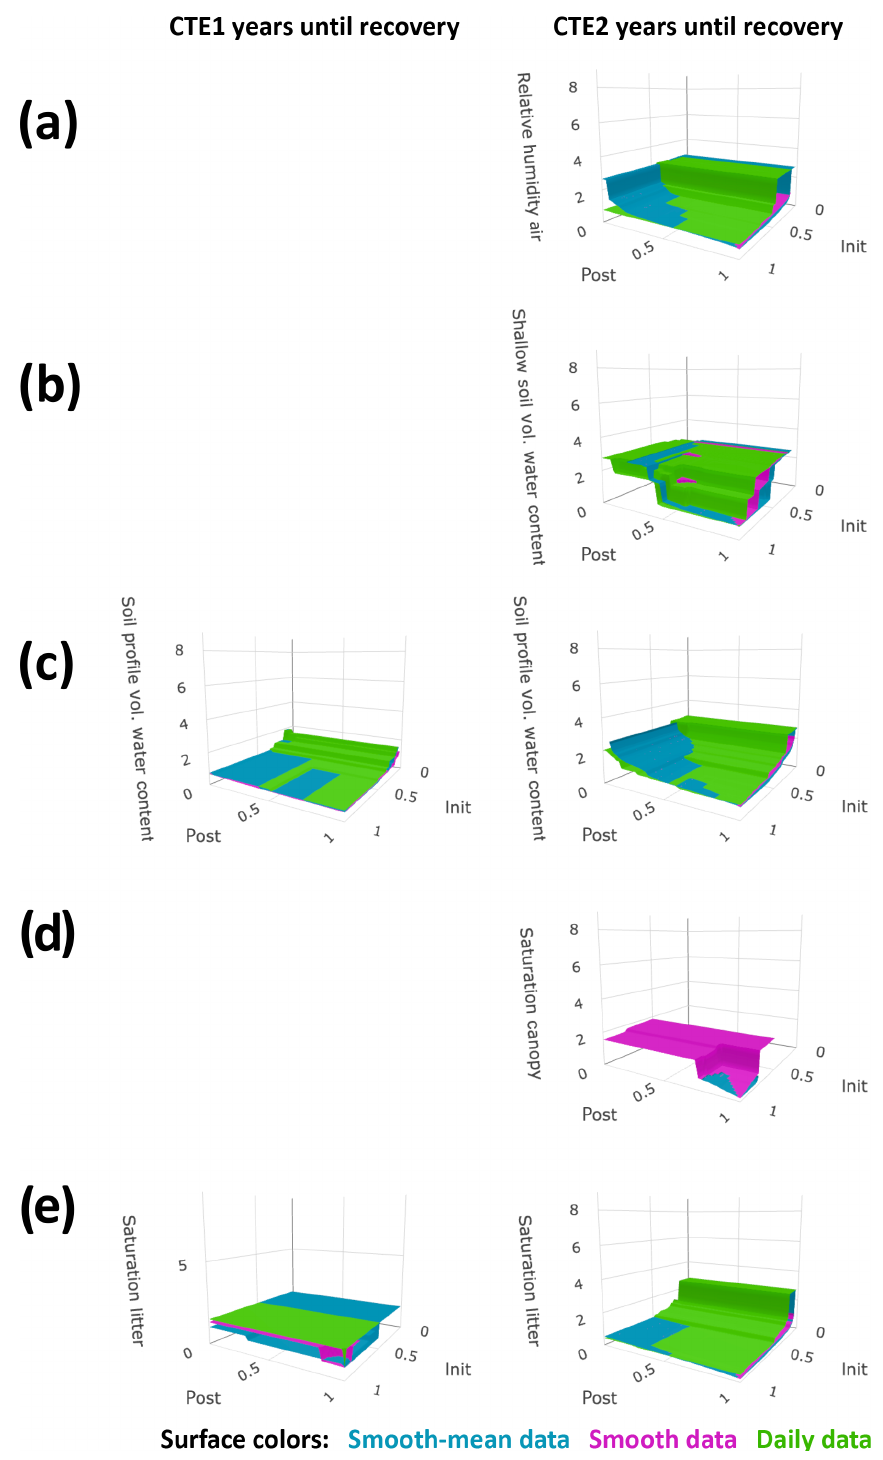
Figure 4. Sensitivity studies on secondary factor calculated recovery times. All markings are the same as in Fig. 3. Plots show (a) air relative humidity, (b) soil moisture shallow, (c) soil moisture profile, (d) low canopy leaf saturation, and (e) litter leaf